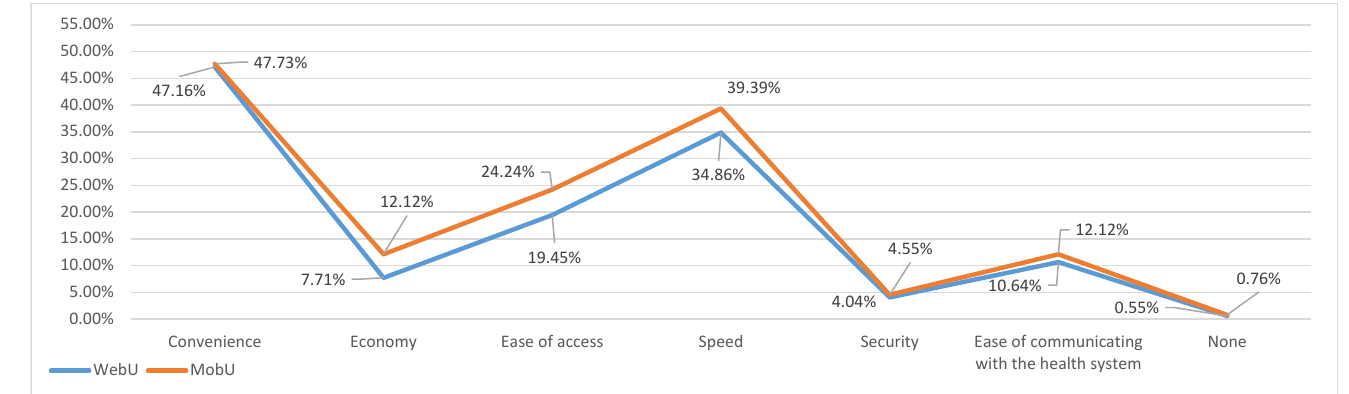
Figure 4. Advantages of ICTs for health services (by user profile).